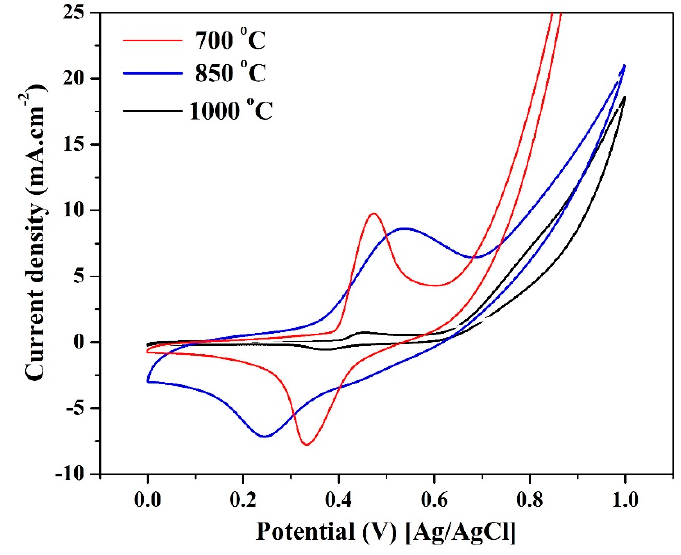
Figure 7. Influence of the calcination temperature on the ESA of the activated nanofibers containing 10 wt % Sn.